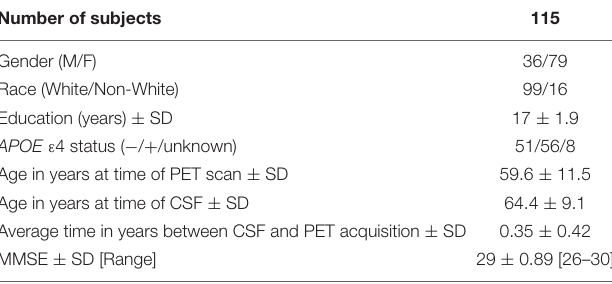
TABLE 3 | Cerebrospinal fluid results of the test group.